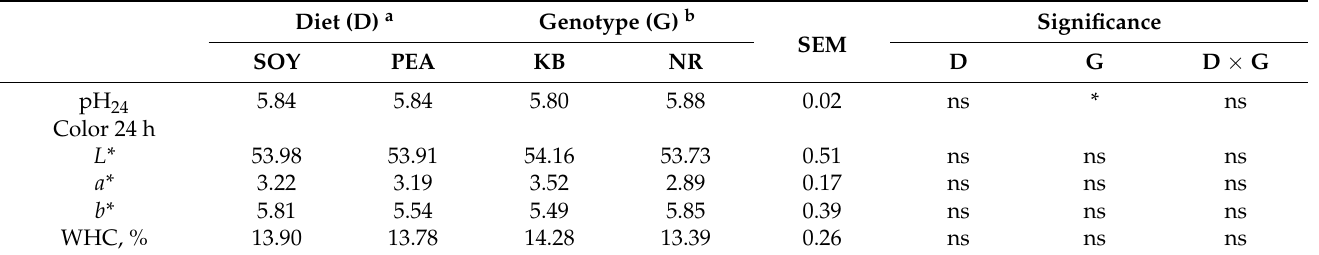
Table 3. Effect of genotype and diet on the physico-chemical properties of the breast muscle of broiler